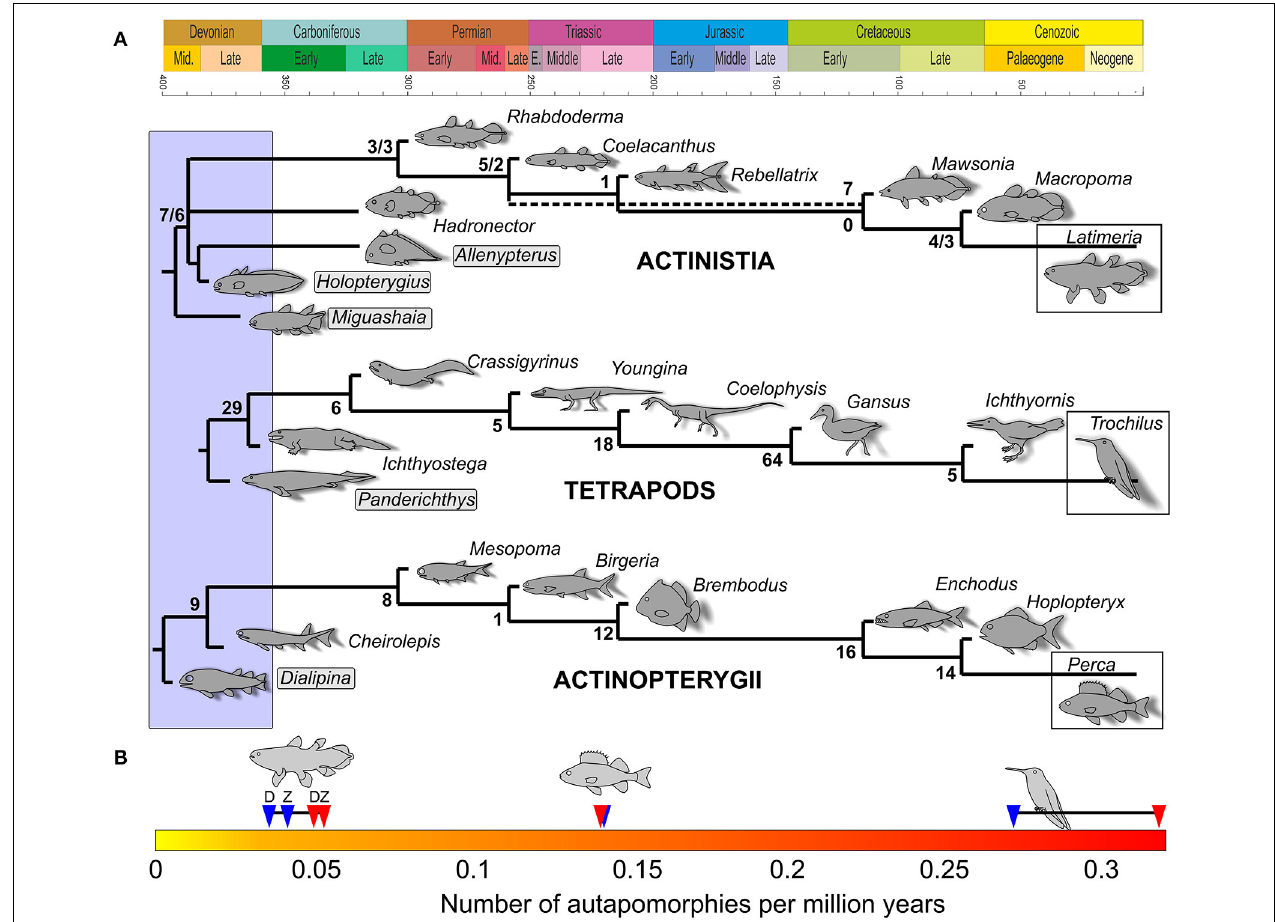
FIGURE 2 | (A) Cladograms of the three crown-vertebrate clades included within a time frame. Numbers indicate uniquely derived apomorphies supporting each node [for actinistians, numbers separated by a slash bar are counted based on data from Dutel et al. (2012) and Zhu et al. (2012), respectively]. (B) Scale indicating the acquisition rate of uniquely derived